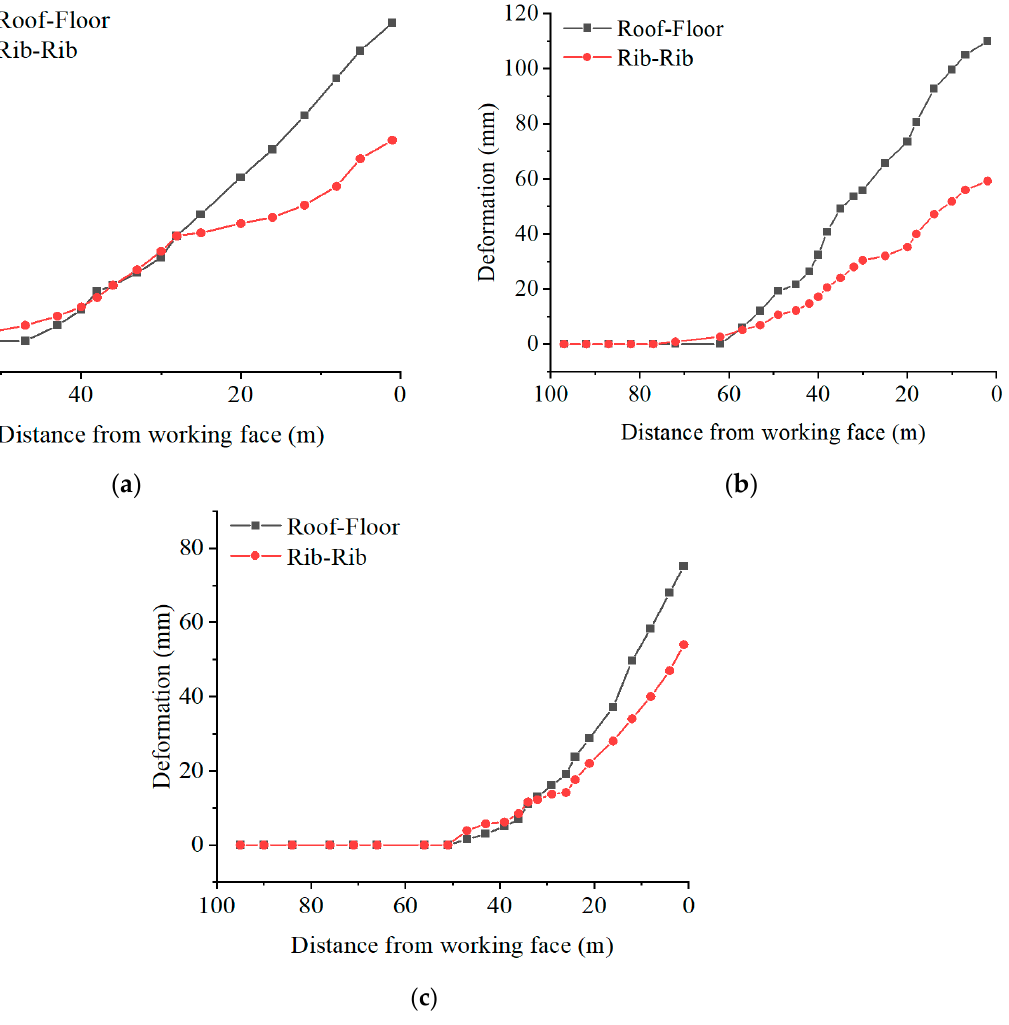
Figure 20. Deformation of the roof-floor and two ribs. ( a ) Station 1# ( b ) Station 2# ( c ) Station 3#.